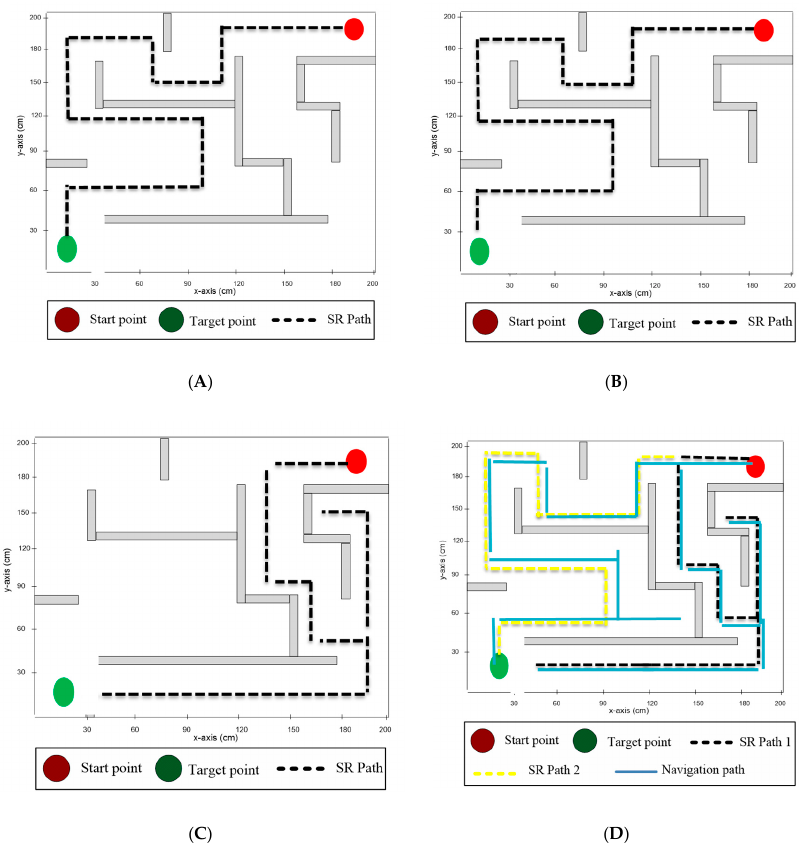
Figure 12. The route of the solver robot using 4 algorithms in testbed # 3. ( A ) Pledge algorithm; ( B ) right-hand algorithm; ( C ) left-hand algorithm; ( D ) MWFS.